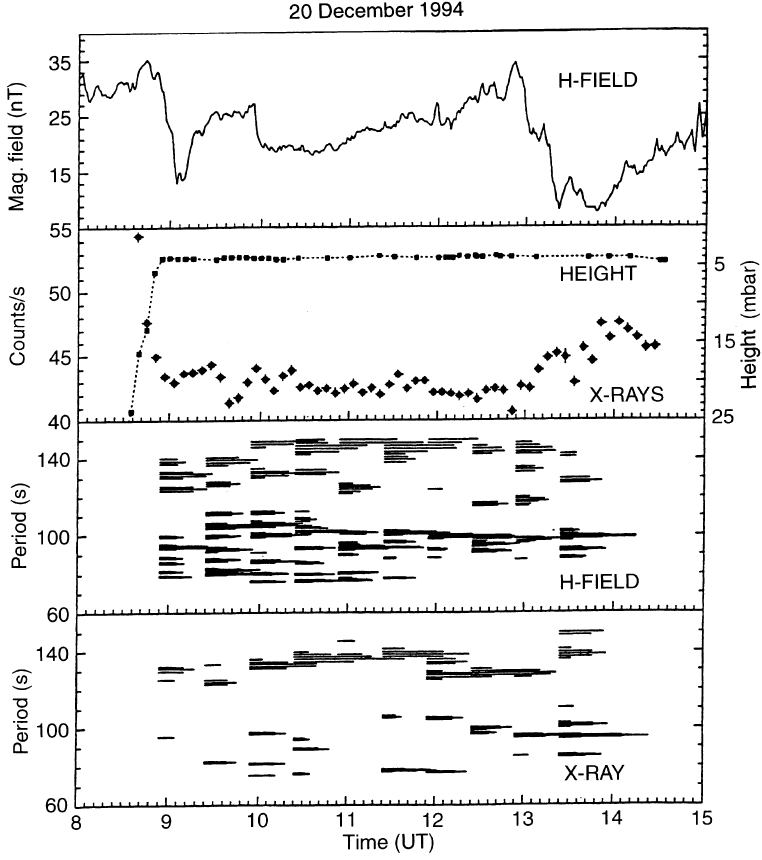
Fig. 3. From top to bottom : the time dependence of H -component of geomagnetic field (Sa˜ o Jose´ dos Campos); the X-ray count rates; and the periods of Geomagnetic and X-ray flux pulsations observed every half hour during balloon flight of 20